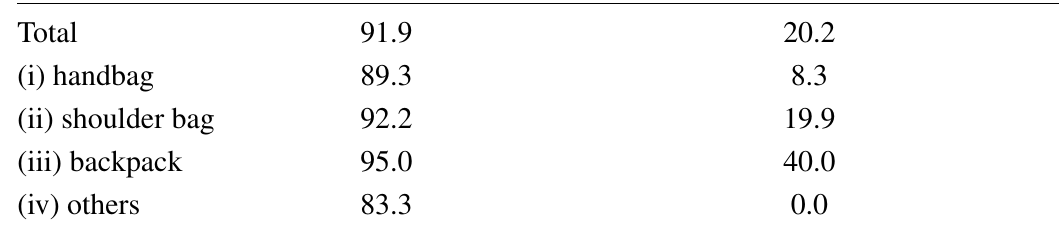
Table 2. Correct classification rates with CASIA-B-BG by the proposed method and the method without matching weights [ %